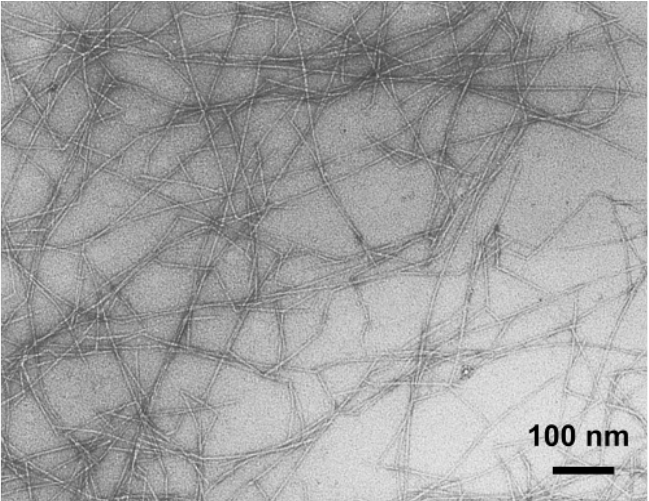
Figure 3. TEM image of dispersions of the 2,2,6,6-tetramethylpiperidine-1-oxyl (TEMPO)-oxidized celluloses with carboxylate contents of 0.9 and 1.5 mmol/g. Images were taken after stirring in water for 10 days [66]. Reproduced with permission from [37]. Copyright 2007 American Chemical